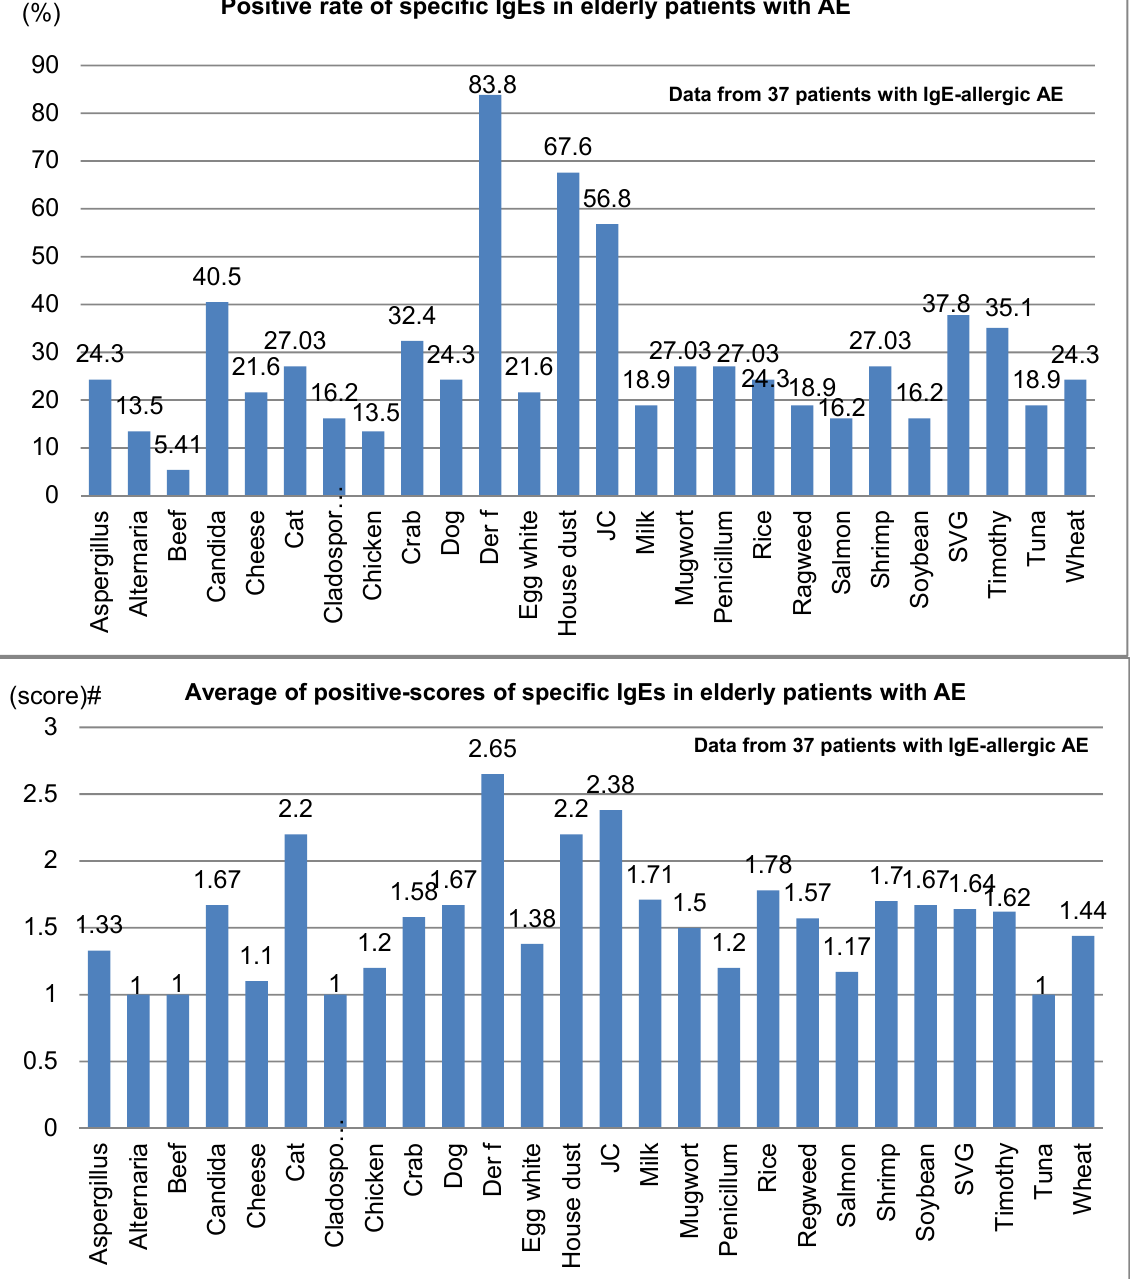
Figure 3. Positive rate ( top ) and average of positive scores ( bottom ) of specific IgEs in elderly patients with atopic eczema. Abbreviations: AE, atopic eczema; Der f, Dermatophagoides farinae ; JC, Japanese cedar; SVG, sweet vernal grass. # Average of class intensity (score) of the positive allergens for multiple antigen simulations test (MAST)-26 or MAST-33; the adjust class intensity for the common 26 allergens are decided as follows: score 1 (mild) = class 1 for MAST26 or class 2 for MAST33; score 2 (moderate) = class 2 for MAST26 or class3 for MAST33; score 3 (strong) = class 3 for MAST26 or class 4, 5 and 6 for MAST33; score 4 (very strong) = over class 3 for MAST26 or over class 6 for